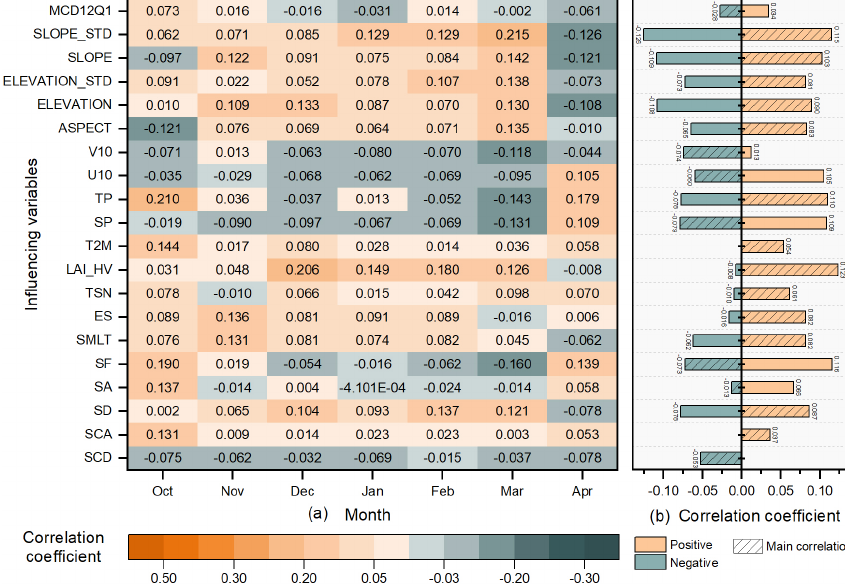
Figure 4. Correlation coefficients between snow density and its influencing variables in each month (a) , and the average value of the positive and negative correlation coefficients, where the main correlation marked as shade refers to the positive or the negative correlation that occurs in more months than the other (b) .